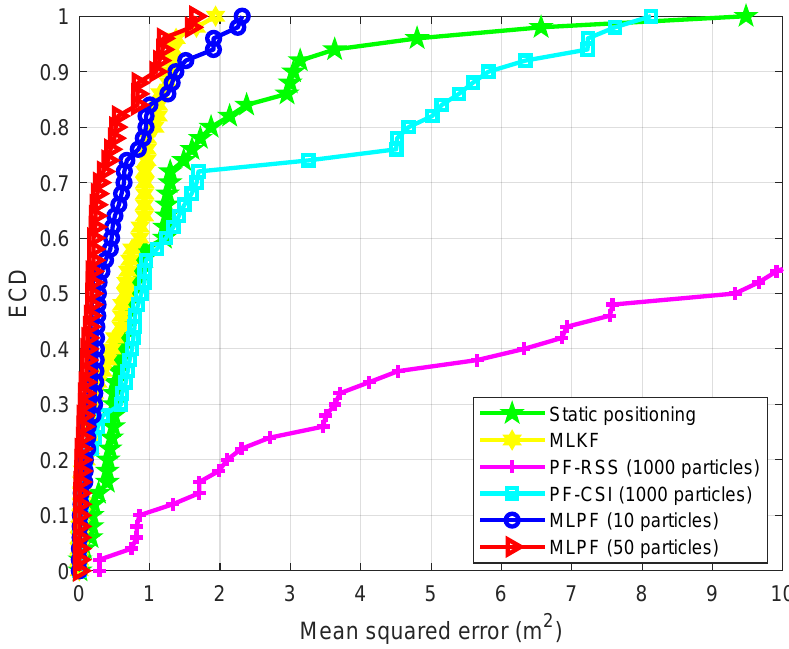
Figure 4. Positioning error cumulative distribution (ECD) (empty room).